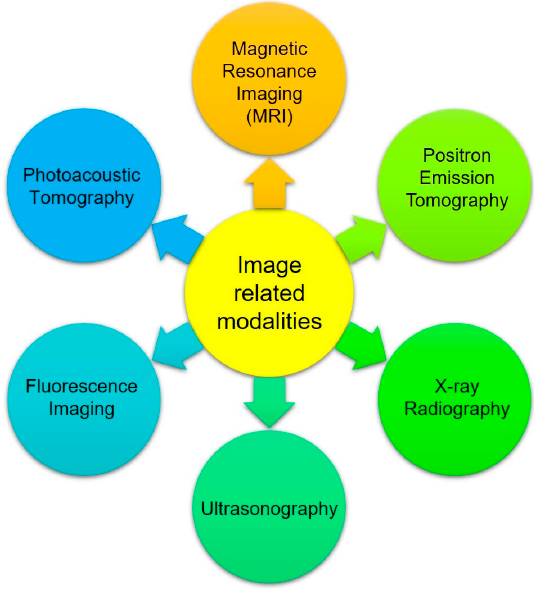
Figure 3. Image-related modalities.